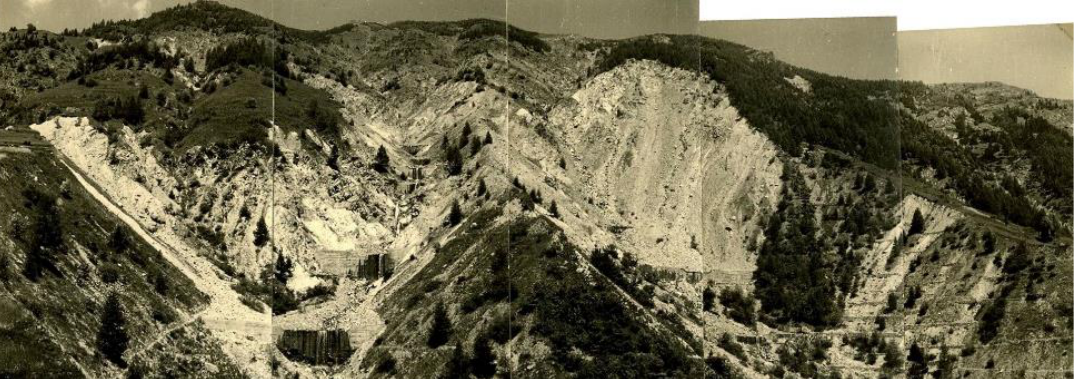
Figure 5. A horizontal pan of the left slope of the Ischiator catchment, showing widely exposed bare detritus, as it appeared in 1957 (archives of the IRPI-CNR, Torino, unpublished).